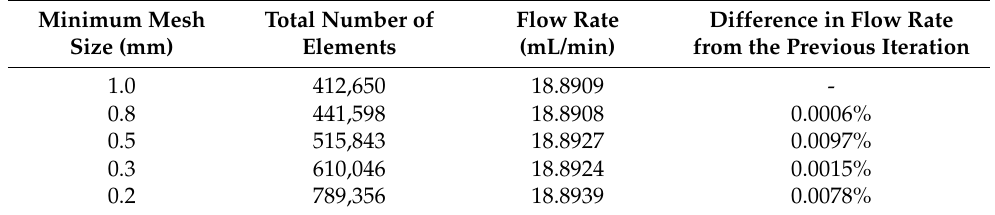
Table A1. Mesh sensitivity analysis for the flow driven by thermal transpiration membrane with Diamond on the inlet surface at 16.2 W power input from the